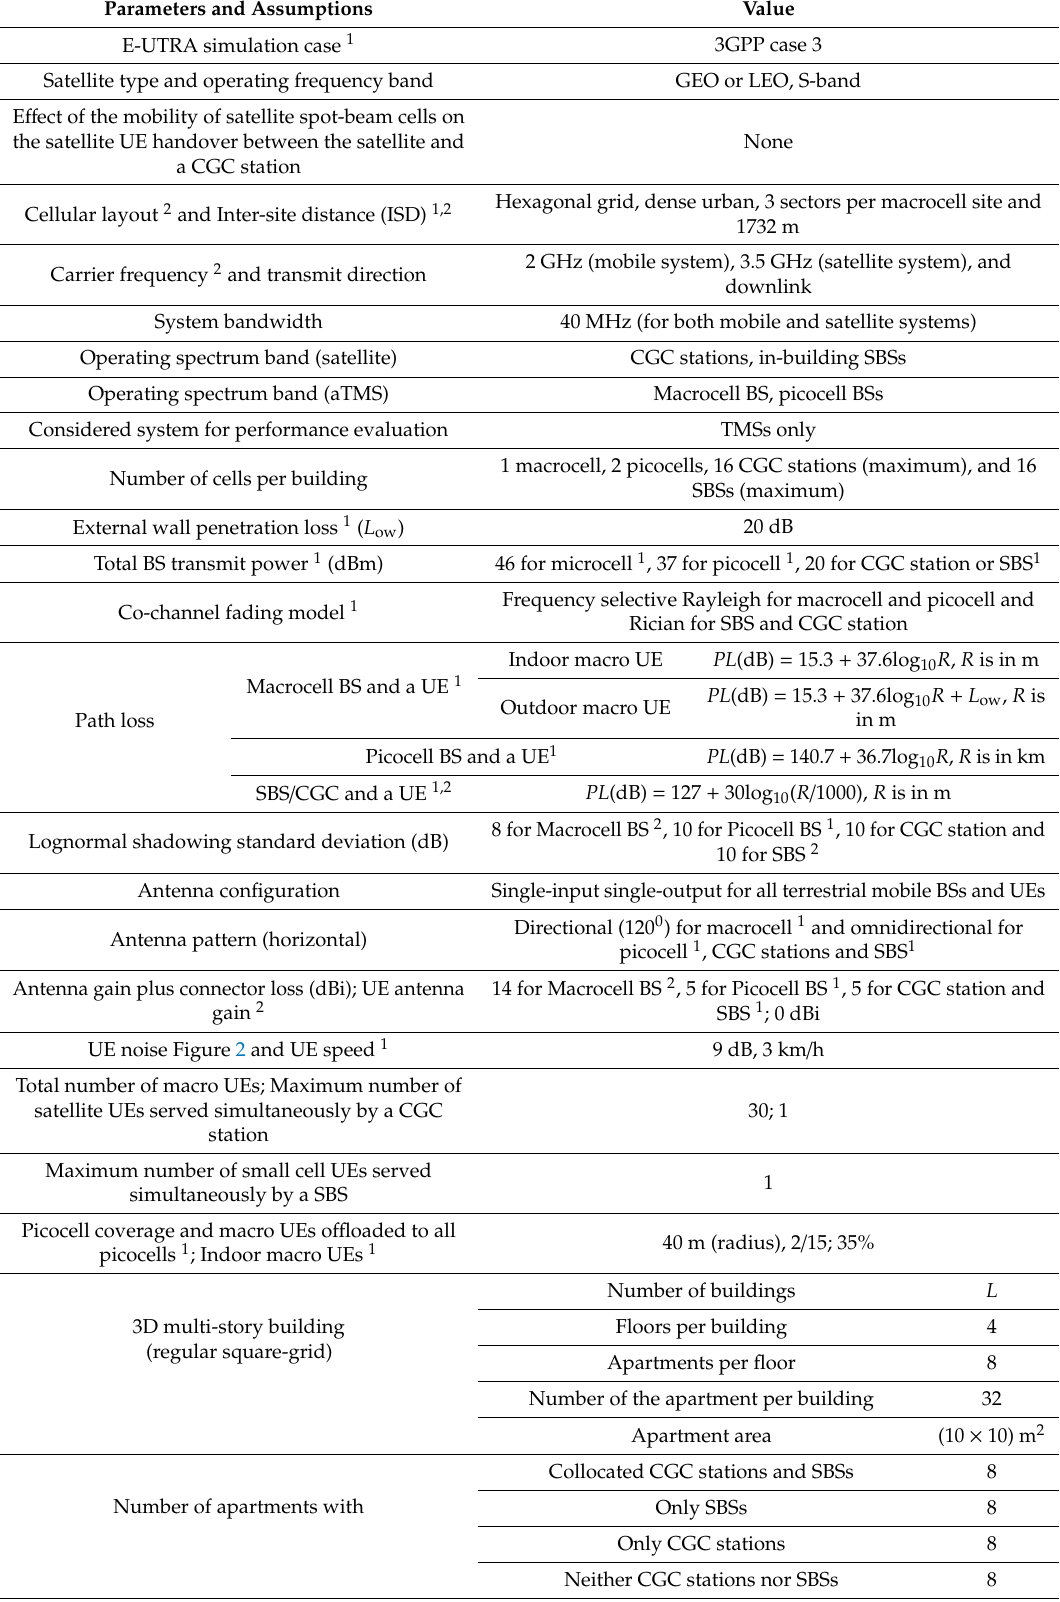
Table 1. Default parameters and